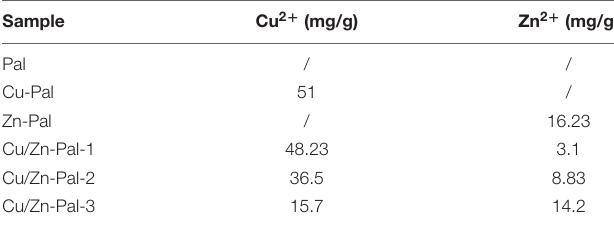
TABLE 2 | The Cu 2 + /Zn 2 + concentration in the complexes.